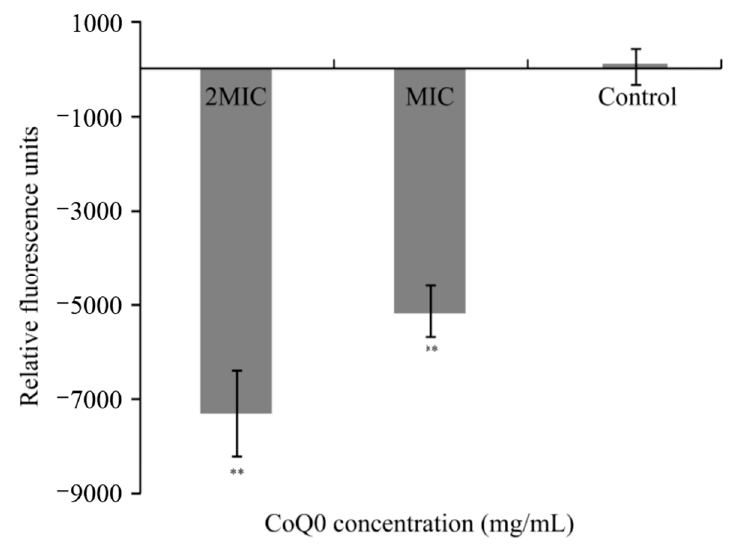
Figure 5. Effects of CoQ 0 treatment on the membrane potential of S. Typhimurium ATCC 14028. Values represent the means of triplicate measurements. Bars represent the standard deviation ( n = 3). Control represents no CoQ 0 added. ** p < 0.01 compared with the